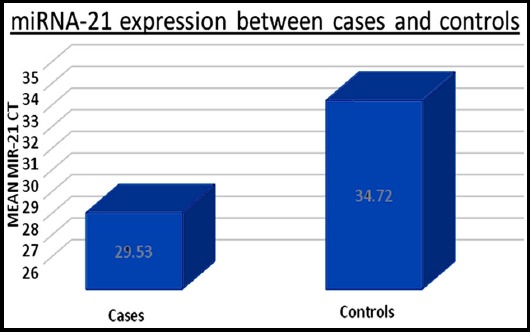
MiR- 21 is upregulated in Oral cancer as indicated by lower CT. MiR 21 expression in serum of Oral cancers and healthy controls determined by qRT-PCR (quantitative reverse transcription polymerase chain reaction. *p≤0.05.